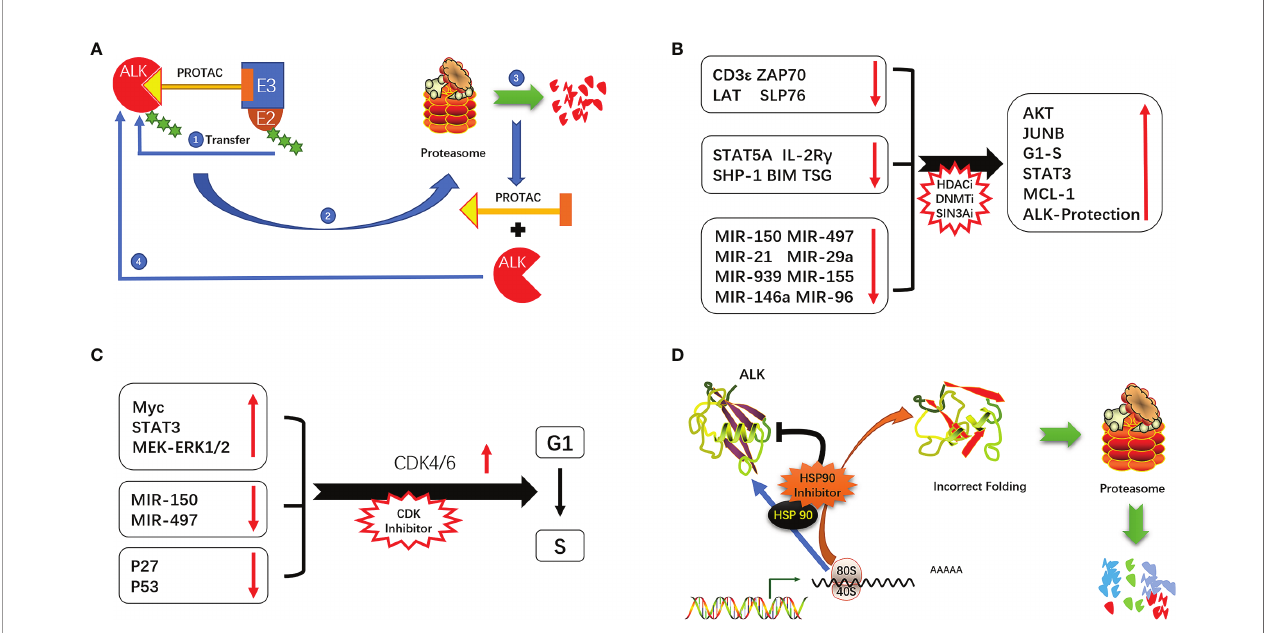
FIGURE 4 | (A) Mechanism of action of PROTAC. (B) ALK signaling-mediated cycle operation. (C) Epigenetic alterations promote the development of ALK-positive ALCL. (D) Mechanism of ALK inhibition by